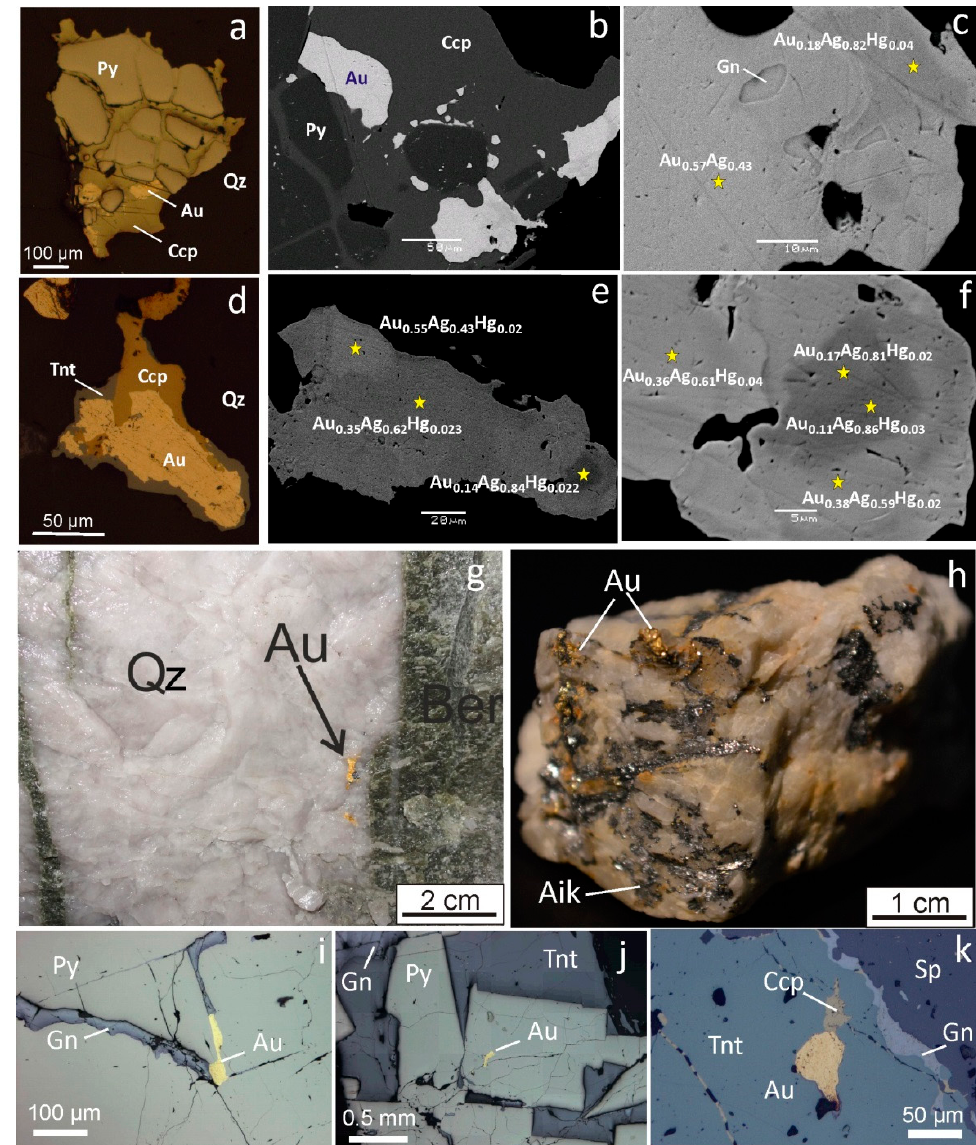
Figure 4. Native gold in the Vorontsovka ( a – f ) and Berezovsk deposits ( g – k ). ( a – f ) Inhomogeneous native gold in quartz veinlet ( c —details of b , f —details of e ). ( g, h ) Macroscopic native gold: ( g ) native gold 1.5 × 8 mm near the contact of quartz and beresite (Ber), ( h ) native gold 1–4 mm associated with aikinite in quartz-carbonate vein. ( i – k ) Native gold in pyrite ( i, j ) and tennantite ( k ). Ccp—chalcopyrite, Tnt—tennantite, Gn—galena, Sp—sphalerite, Aik—aikinite, Qz—quartz. ( b, c, e, f ) BSE images, ( d, e ) details of ( c ).